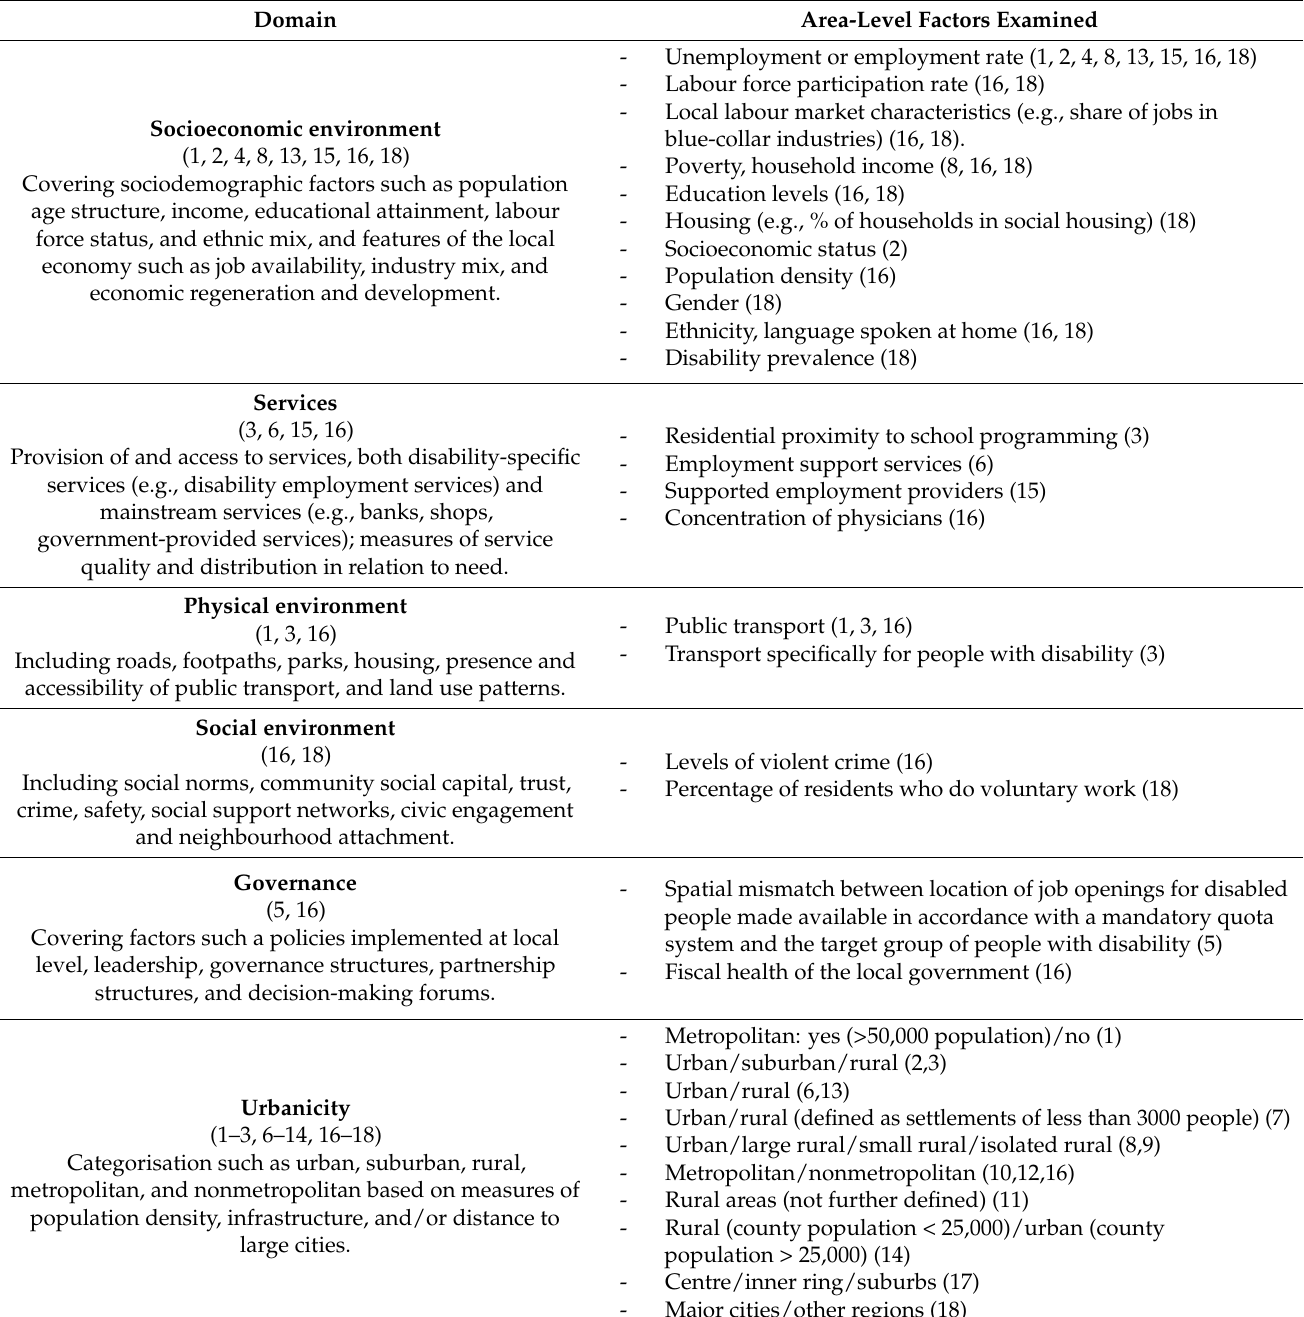
Table 2. Area-level factors examined by